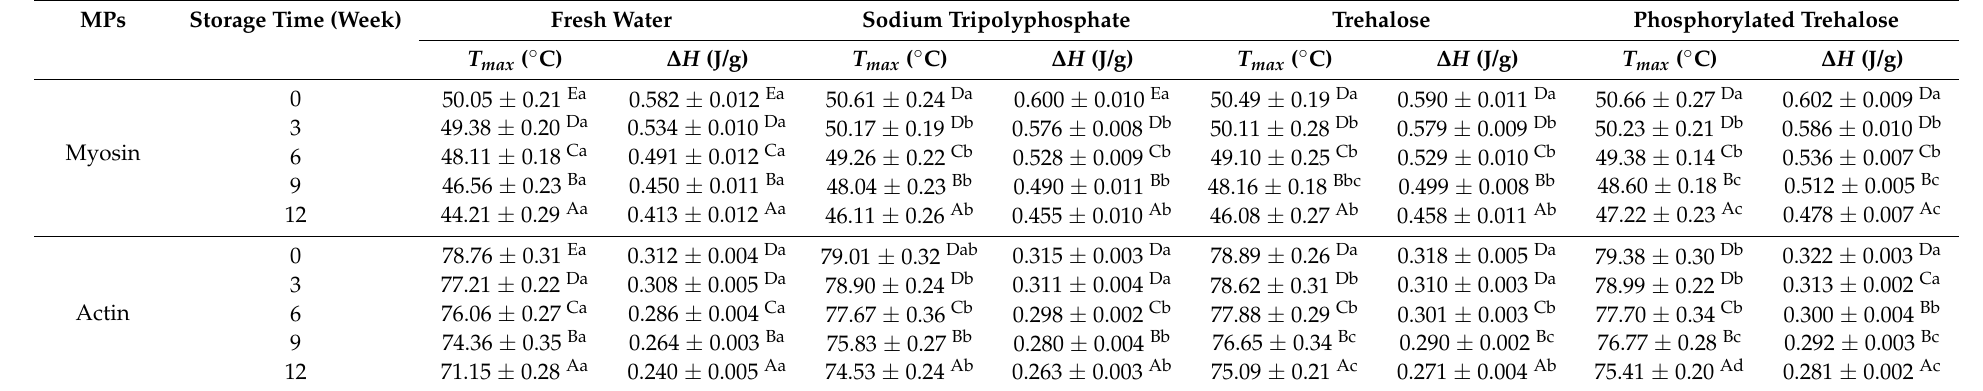
Table 2. Changes in thermal stability ( T max and ∆ H ) of MP (myosin and actin) in peeled shrimp soaked with fresh water, sodium tripolyphosphate, trehalose, and phosphorylated trehalose during frozen